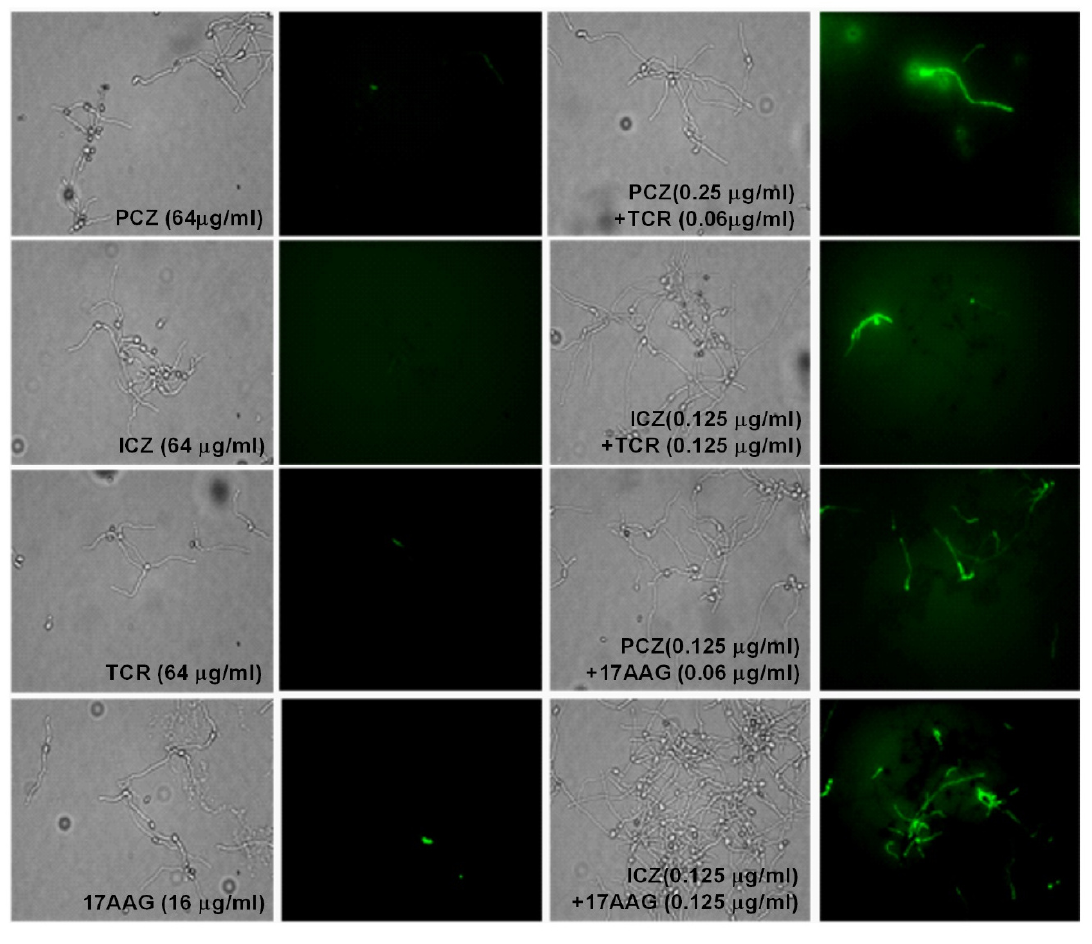
FIGURE 4: Detection of metacaspase (caspase-like) activity using CaspACE FITC-VAD-FMK probe in germlings of S. prolificans (isolate 1) treated with PCZ or ICZ in combination with TCR or 17AAG. Shown are fluorescent images of activated metacaspases of S. prolificans germlings treated with drugs alone and in combination with TCR or